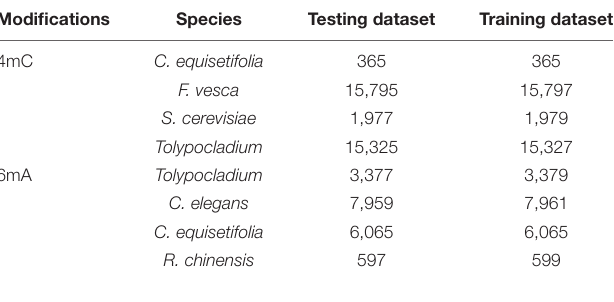
TABLE 1 | Summary of benchmark datasets used in this